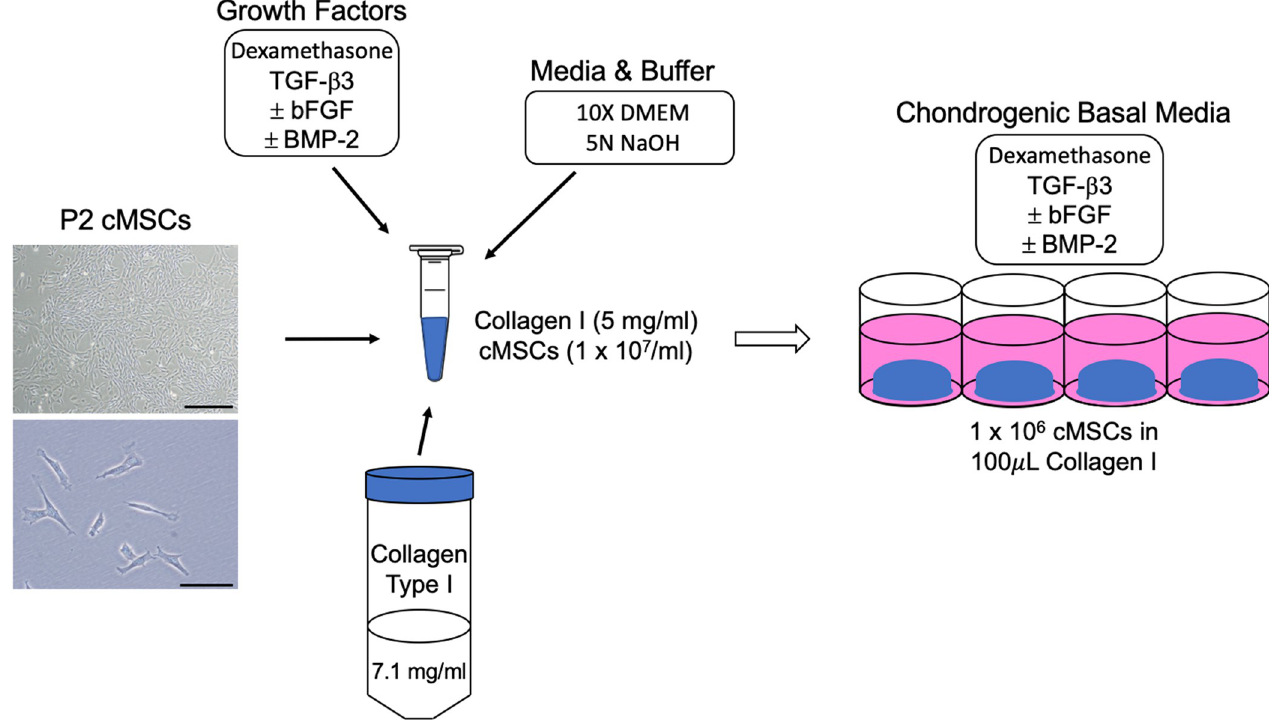
Table 1: Final volume of collagen gel and cell mixture was selected based on number of 100 μ L cMSC/collagen constructs required per experiment (top row). Collagen Type I (4˚C) was pipetted into a chilled 50 mL conical tube. Described amounts of 10X DMEM, 5N NaOH, and 1X DMEM (all 4˚C ) were incorporated. cMSCs (5 x 10 7 /